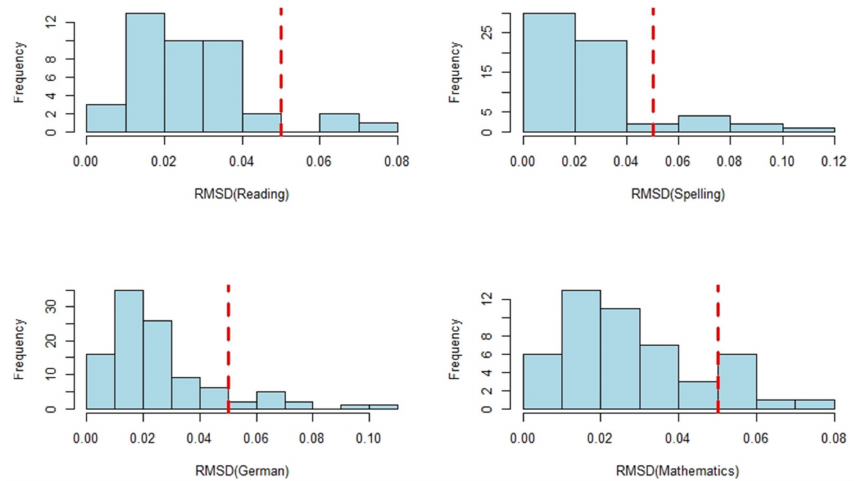
Figure 1. Empirical distribution of the RMSD for the binary items on the reading, spelling, mathe- matics, and German tests. The dotted line indicates the cutoff value of 0.05 used to flag DIF items.